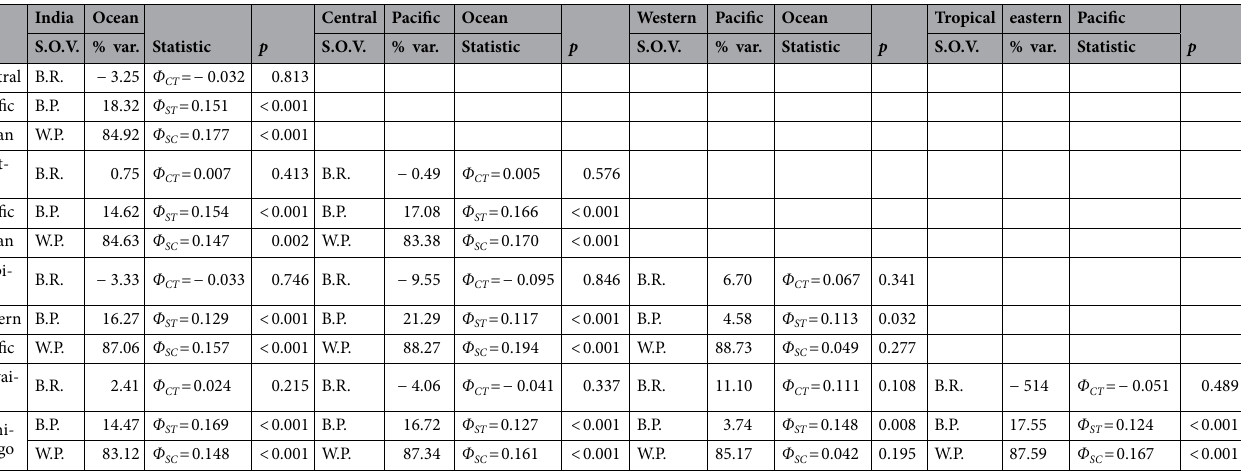
Table 5. Between region pairwise AMOVA of nDNA Tamura & Nei 31 distances in Echinothrix calamaris clade 1. S.O.V. source of variation, B.R. between regions, B.P. between populations within regions, W.P. within populations, % var . percentage of variation. n.b. Tropical eastern pacific = Clipperton Island.